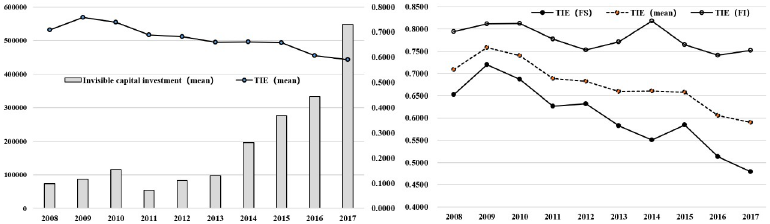
Fig 1. Trends in average invisible capital investment and technical innovation efficiency (TIE) of listed companies in the internet industry affiliated with China from 2008 to 2017. (left) The average numbers of invisible capital investments and TIE. (right) The average TIE for companies with financing innovation, without financing innovation, and all companies in the industry. (Drawing on the research of William Mann [7], Semyon Malamud and Francesca Zucchi [8], the increase of net debt and equity is considered financing